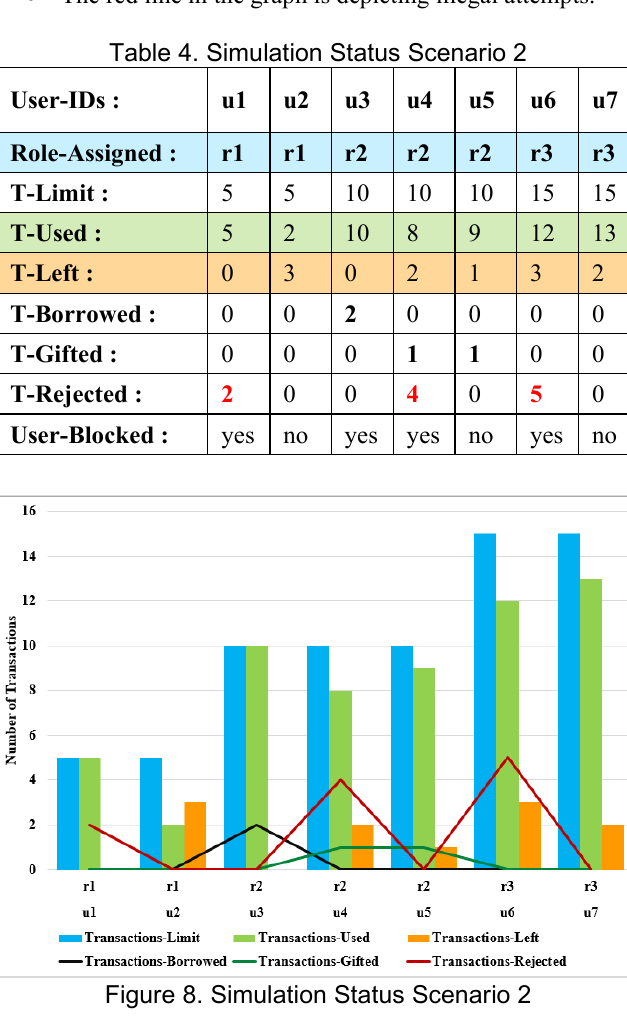
Figure 7. Simulation Status Scenario 1